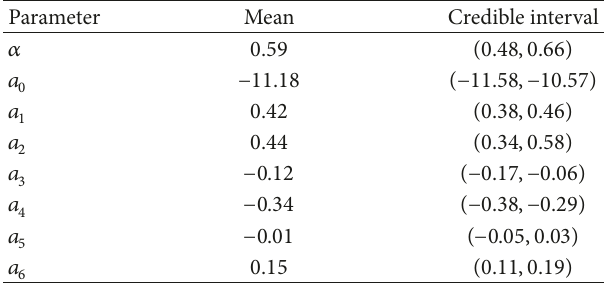
Table 1: Posterior means and 95 % credible intervals for the model